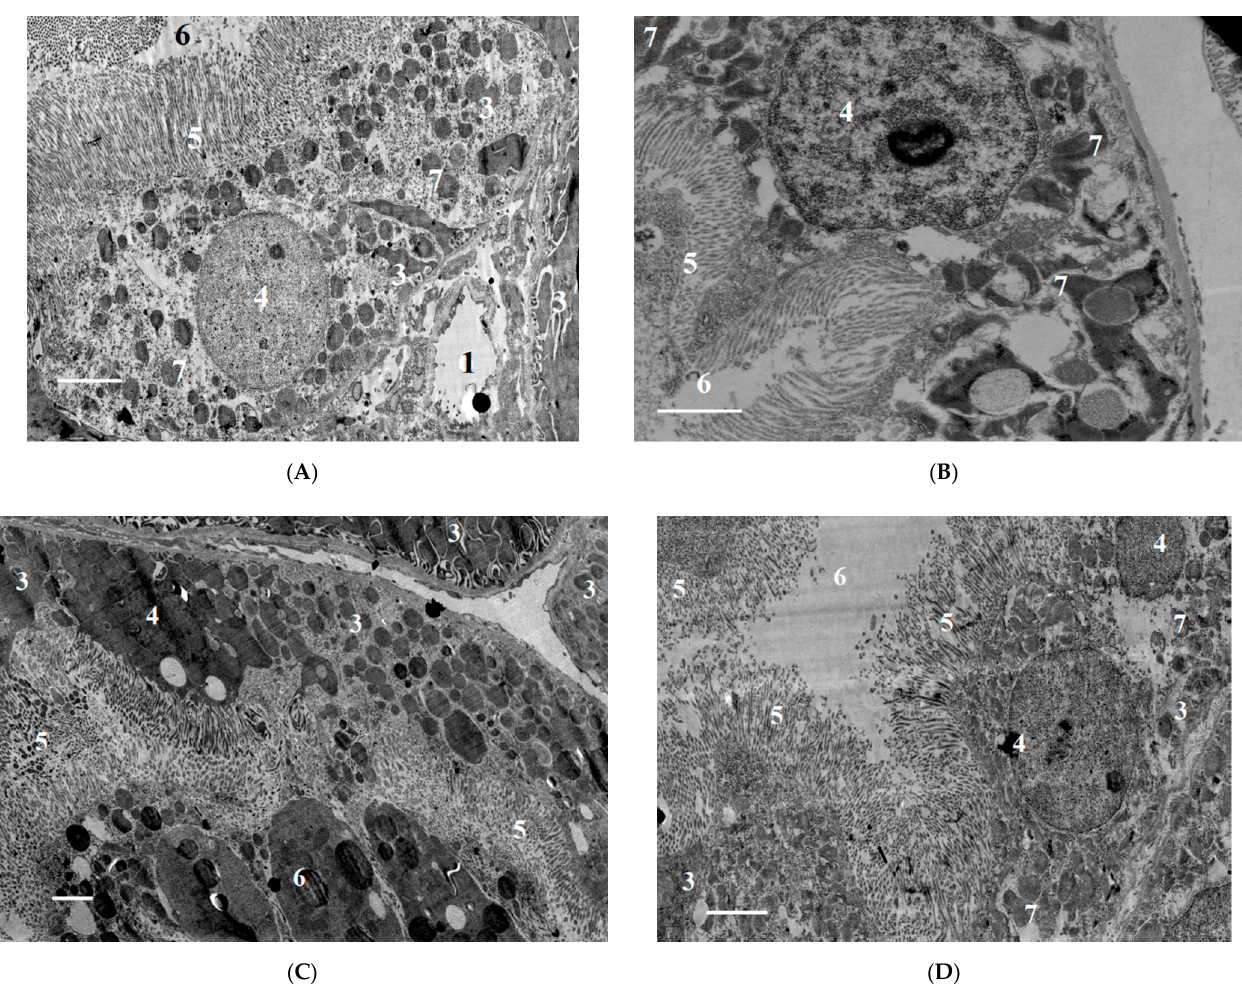
Figure 10. ( A )—control; ( B )—LD50, 24 h after exposure to POX; ( C )—LD84, 24 h after exposure to POX; ( D )—LD84, 3 days after exposure to POX. ( B – D )—Vacuolization of cytoplasm, degeneration of mitochondria in epithelial cells of proximal tubules. ( C )—Karyopiknosis of nuclei after acute poisoning with a dose at LD84. Increased height of proximal tubule epithelium 3 days after exposure to POX ( D ). 1—capillary lumen, 2—epithelial cell of the distal tubule, 3—epithelial cell of the distal tubule, 4—nucleus, 5—microvilli, 6—tubule lumen, 7—mitochondria. Double contrasting with lead nitrate and uranyl acetate. TEM, scale bar = 2 µm.